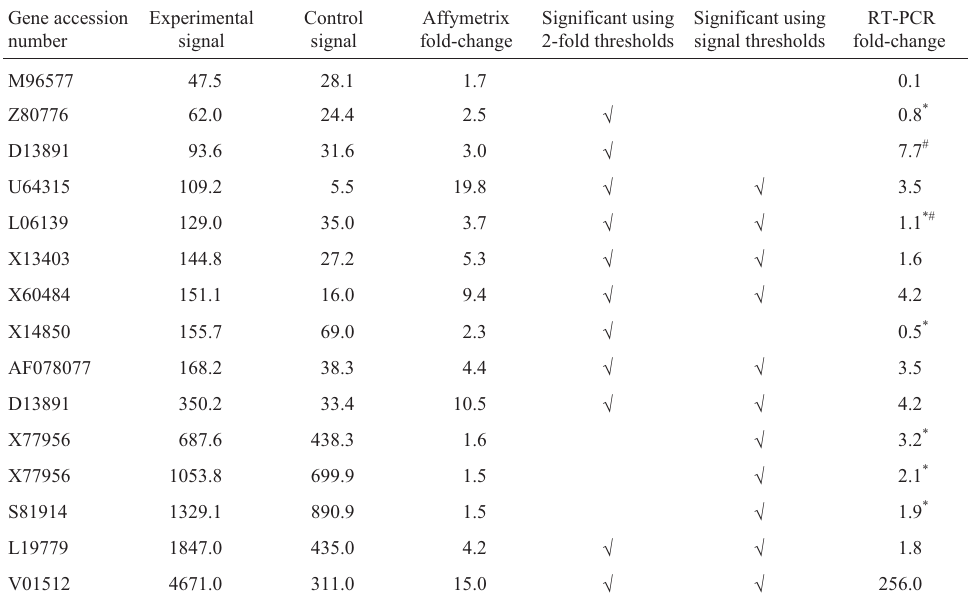
Table 3 - Comparison between the traditional 2-fold threshold and signal thresholds. Gene accession Experimental Control Affymetrix number signal signal